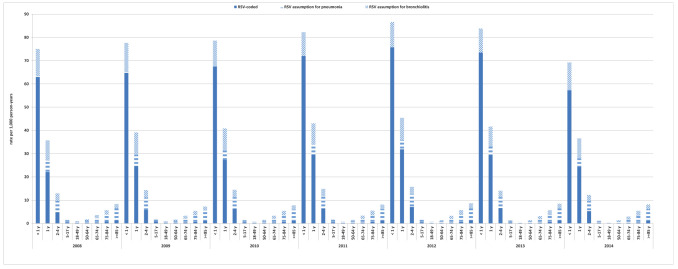
Incidence of respiratory syncytial virus (RSV)-associated disease, 2008-2014. RSV-coded, ICD-9-CM code (079.6, 466.11 or 480.1); RSV assumption for pneumonia, 20% of ICD-9-CM code for all pneumonia (480-486) and influenza with pneumonia (487.0) for <5 years and 9% for ≥5 years; RSV assumption for bronchiolitis 30% of ICD-9-CM code for bronchiolitis (466.1) and obstructive chronic bronchitis (491.2) for <5 years and 9% for ≥5 years.